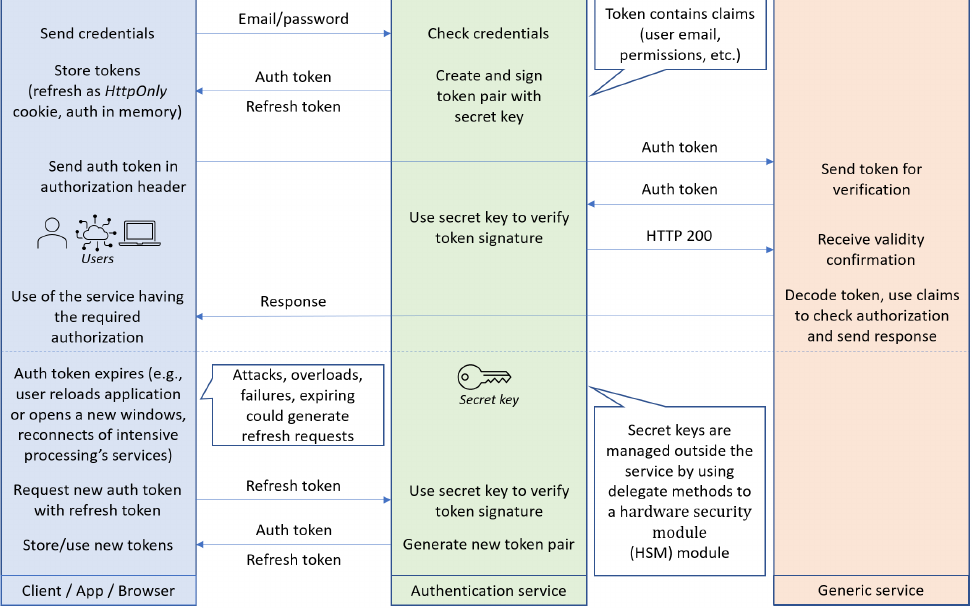
Figure 13. Authentication token